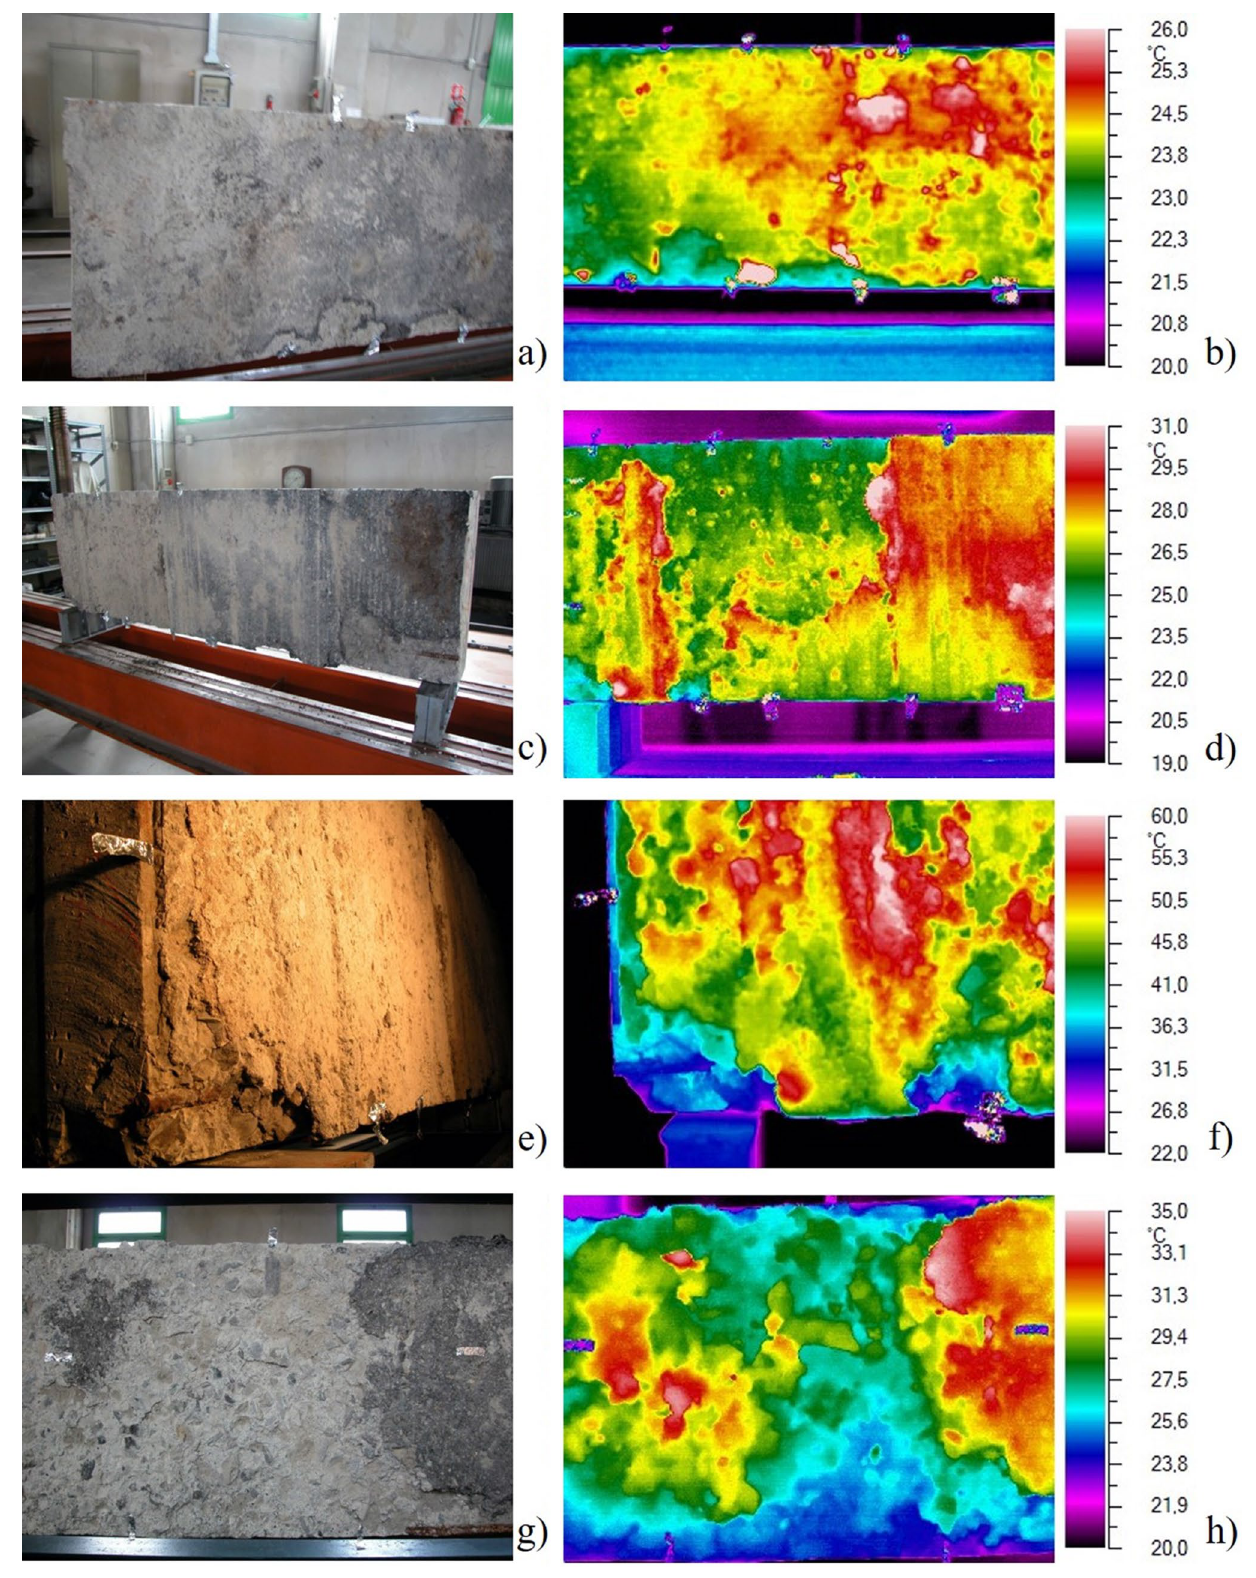
ambient temperature (a real photo of the sample collected); b , d , f and h the images of the analysed samples at different tempera- tures during heating